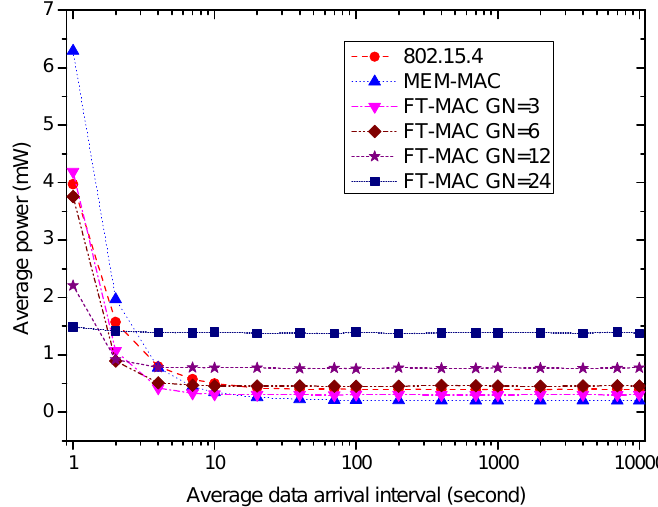
Figure 23. The effect of the average data arrival interval on coordinator average